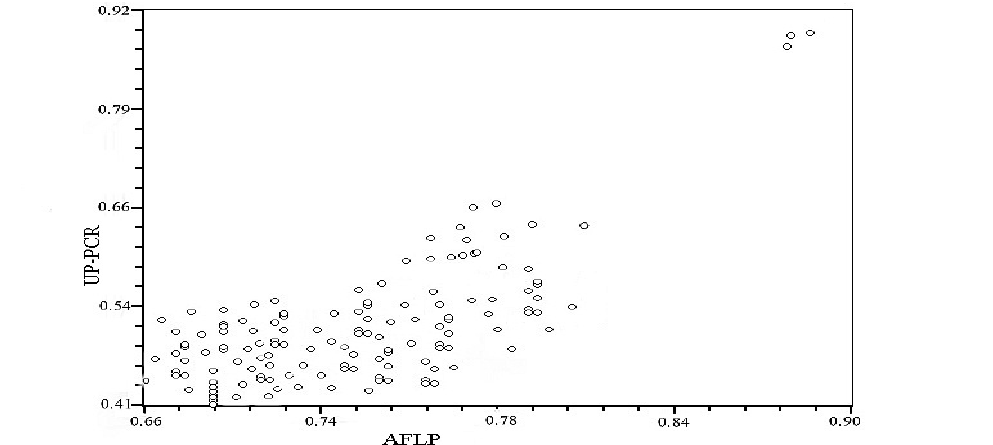
Fig. 3. Comparison of genetic similarity estimates from UP-PCR and AFLP using the Mantel